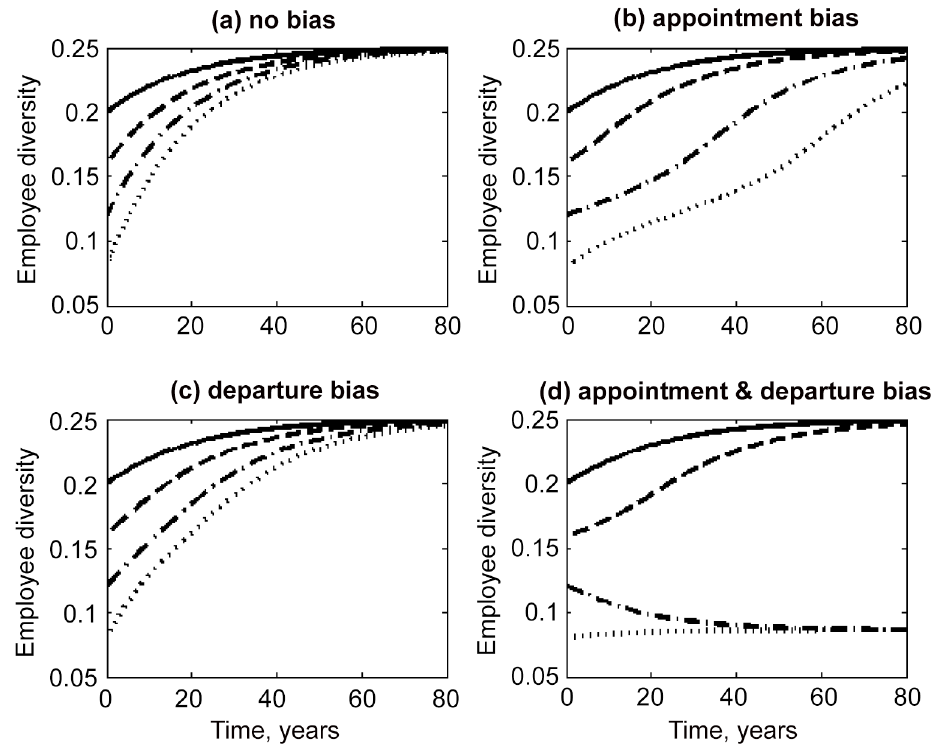
Fig 3. Change in employee diversity over time predicted from Eq 5, for turnover rate of 0.05 per year, applicant diversity of 0.25 and initial employee diversity of 0.08, 0.12, 0.16 and 0.20.